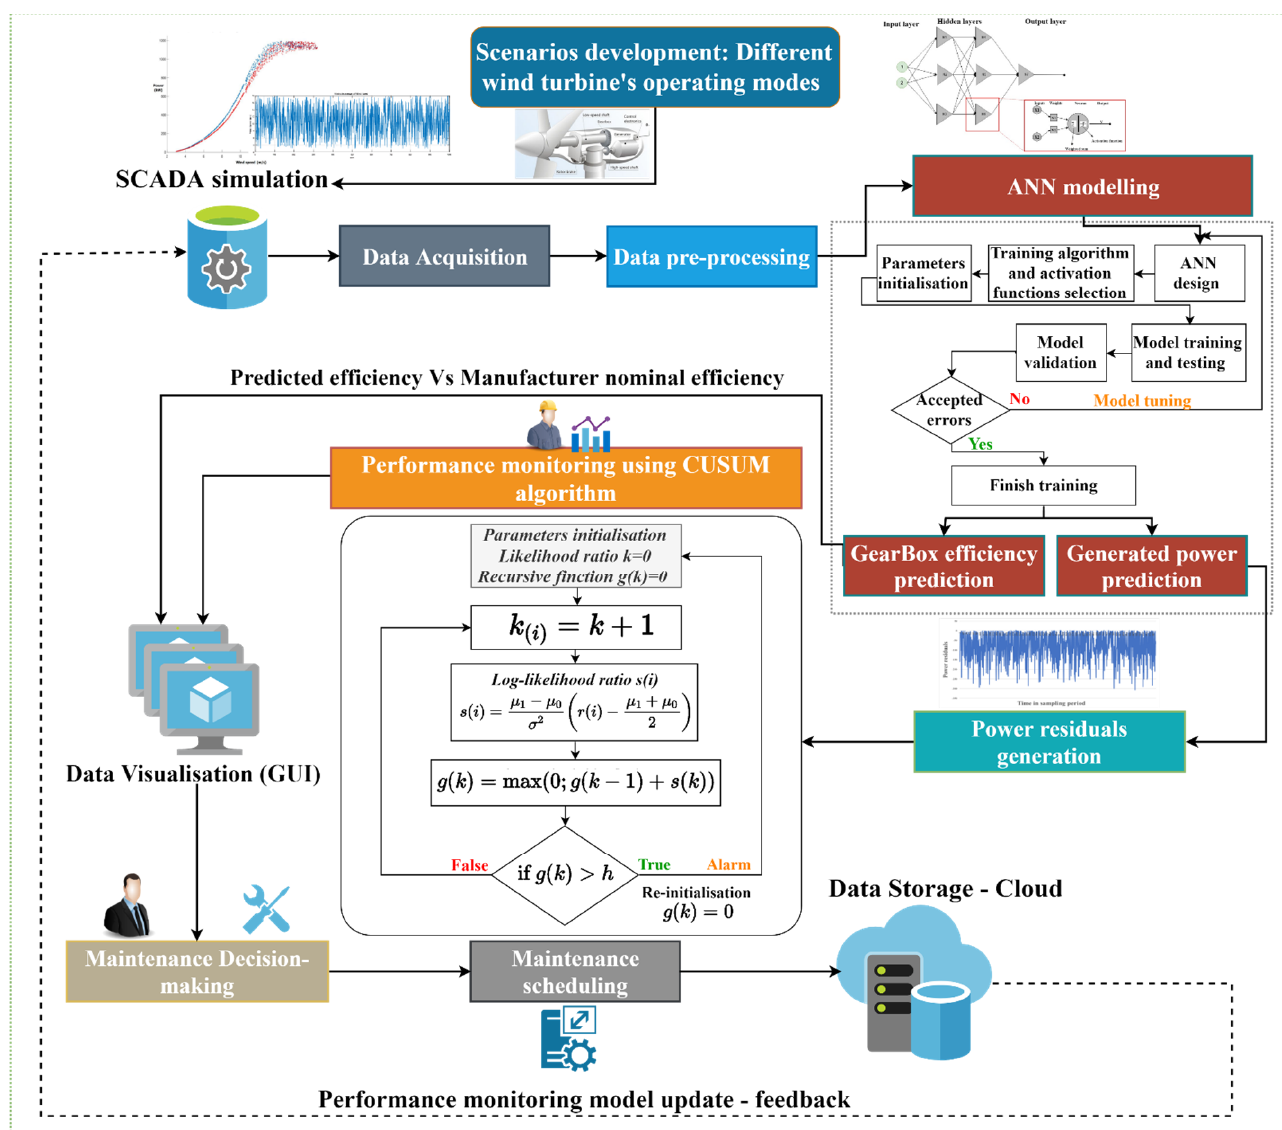
Figure 1. The proposed performance monitoring algorithm.